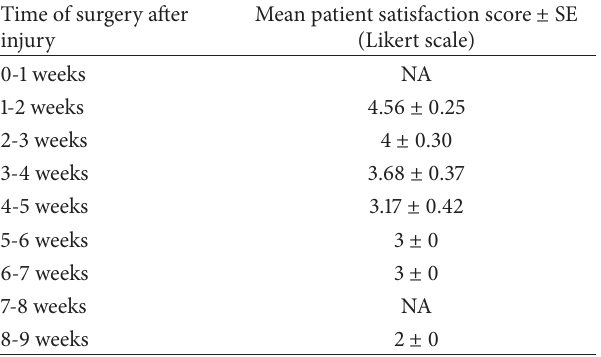
Table 2: Relationship between timing of surgery after injury and mean patient satisfaction score (Likert